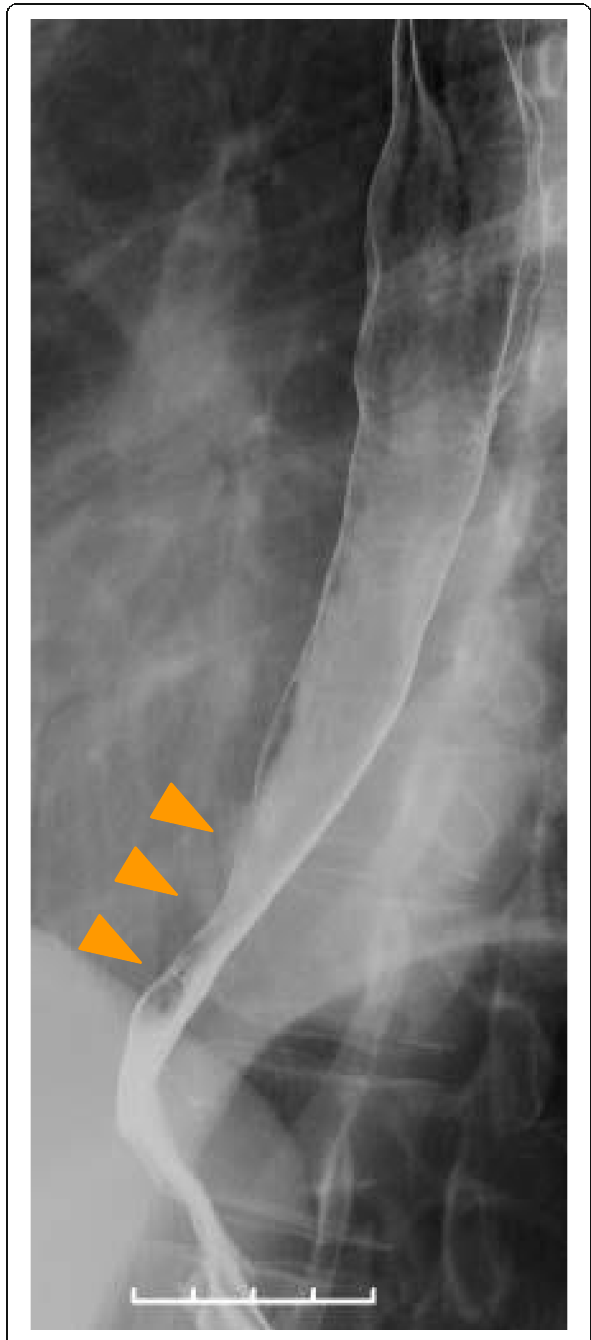
Fig. 2 Esophagography revealed the smooth stenosis at the lower esophagus (arrow